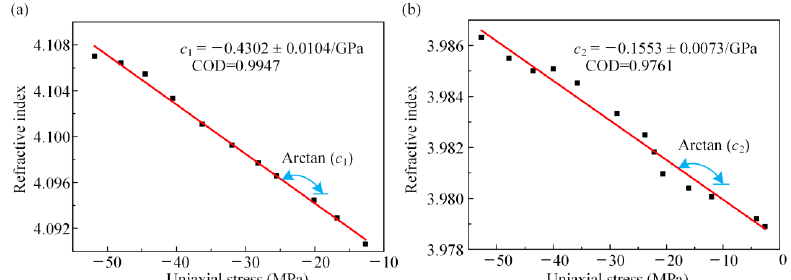
Figure 7. Results of calibration experiment: ( a ) stress-THz coefficients c 1 ; ( b ) stress-THz coefficients c 2 .